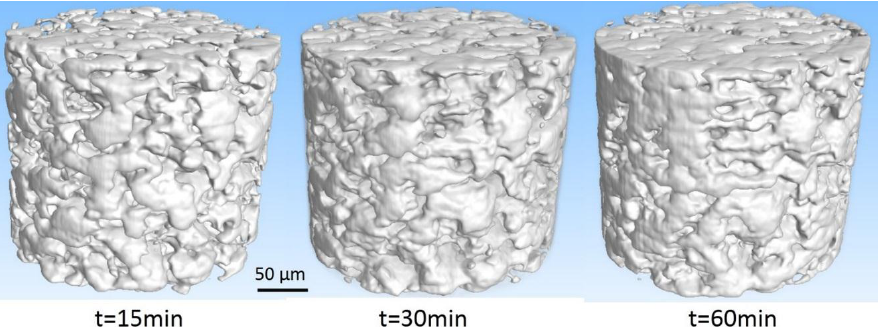
Figure 2. 3D images of the microstructure at different sintering times.